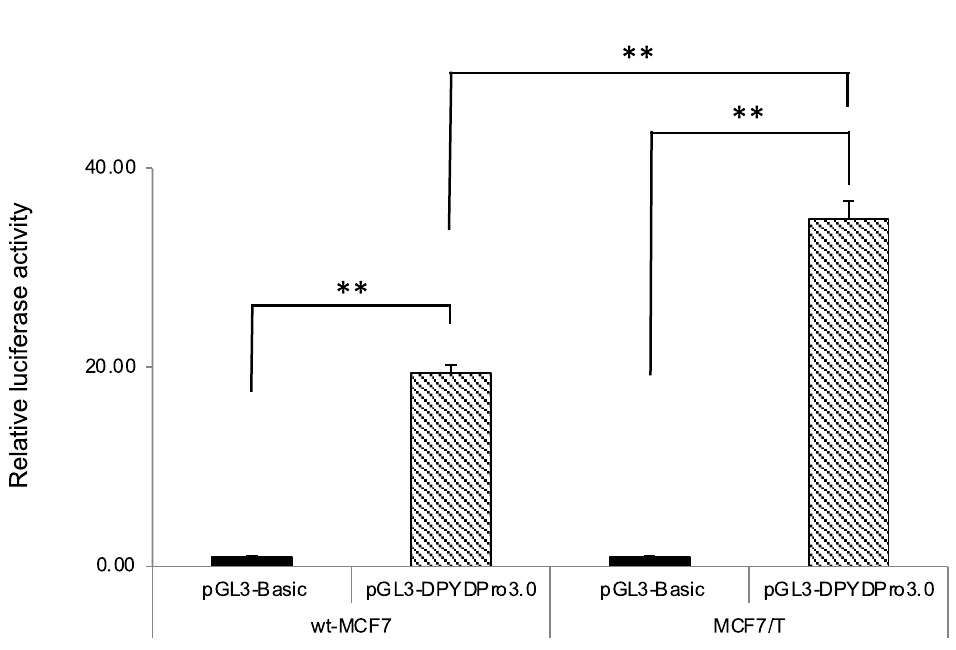
Fig 5. DPYD promoter activity in wild-type MCF7 and tamoxifen-resistant MCF7 cells. Exogenous promoter activity of DPYD was measured by transient transfection assay of the 5 0 region of DPYD with the luciferase reporter gene. Relative luciferase activity normalized to pGL3-Basic in each cell line is expressed. The experiments were repeated independently at least three times, and one representative result is provided in the figures. NS: not significant, �� p < 0.01, using unpaired Student’s t